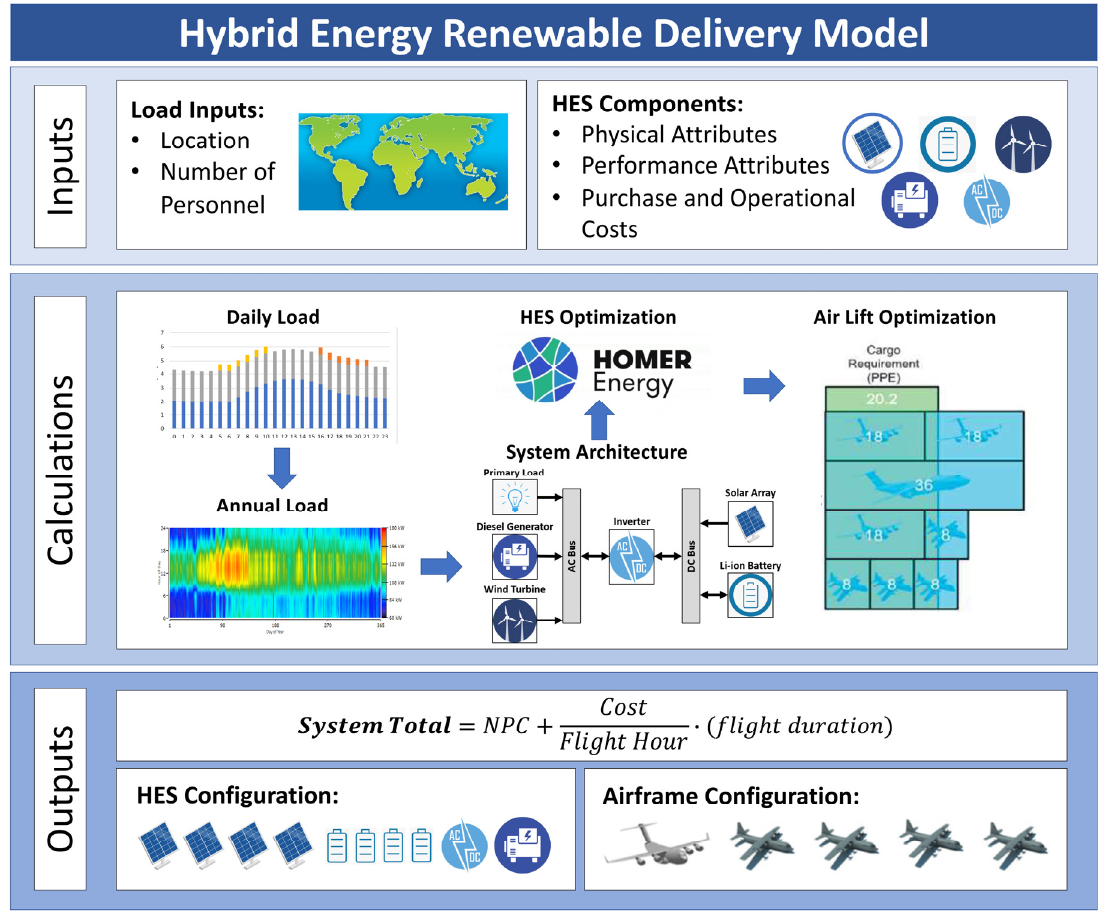
Figure 1. An overview of the input parameters, calculations performed, and outputs of the hybrid energy renewable delivery system (HERDS) model [31]. HES: hybrid energy system and NPC: net present cost.